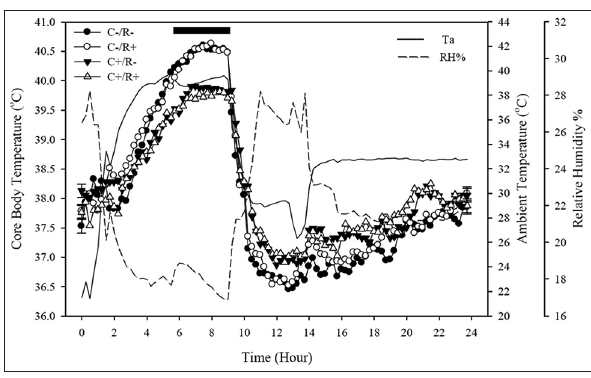
Figure-3: Mean (±SE) core body temperature of rats while under acute heat stress (HS) challenge (T =35.86±0.37°C; a 00:00-09:00 h) on day 29 of trial. Thermoneutrality (ambient temperature; T =23.15±0.04°C) was maintained a between days 0 and 28. Then, HS was imposed in two subsequent phases; an acute HS wave on day 29 of the trial, followed immediately by chronic HS (T =32.28±1.00°C); a until the end of the trial (day 34). The treatments were hypercholesterolemia-inducing (HC) diet (C+) and/or resveratrol (R+): C-/R- (control) group fed a control diet throughout the trial. The C+/R- group consumed the HC diet (containing 1% purified cholesterol along with 0.5% cholic acid, with high-fat-based mixture), throughout the trial. The C-/R+ was fed the control diet and received a dose of 13 mg/kg BW/day of purified trans-resveratrol by oral gavage during the past 5 days of the trial. The C+/R+ group consumed the HC diet and received the R+ treatment as explained. Horizontal bar signifies a cholesterol by time interaction (p<0.05).